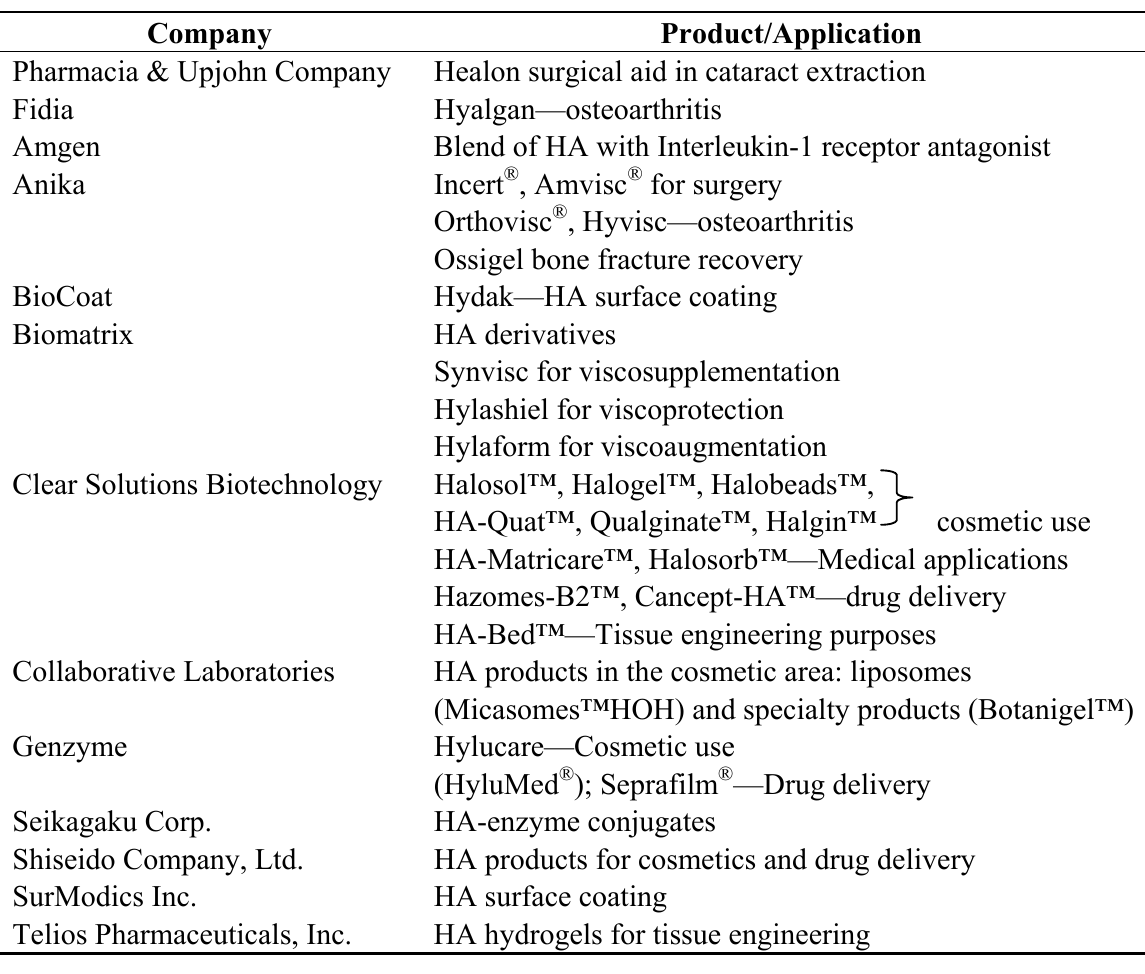
Table 6. List of hyaluronic acid (HA) or HA-derived products developed by different companies (Adapted from